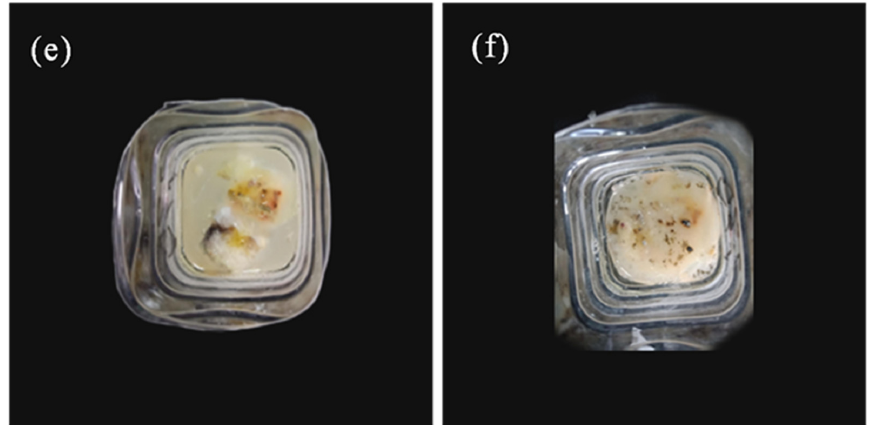
Figure 9. The morphology of CTS-starch-based foams in deionized water ( a ): start time, ( b ): 3 days later, ( c ): 10 days later, ( d ): 18 days later, ( e ): 24 days later, ( f ): 30 days later.